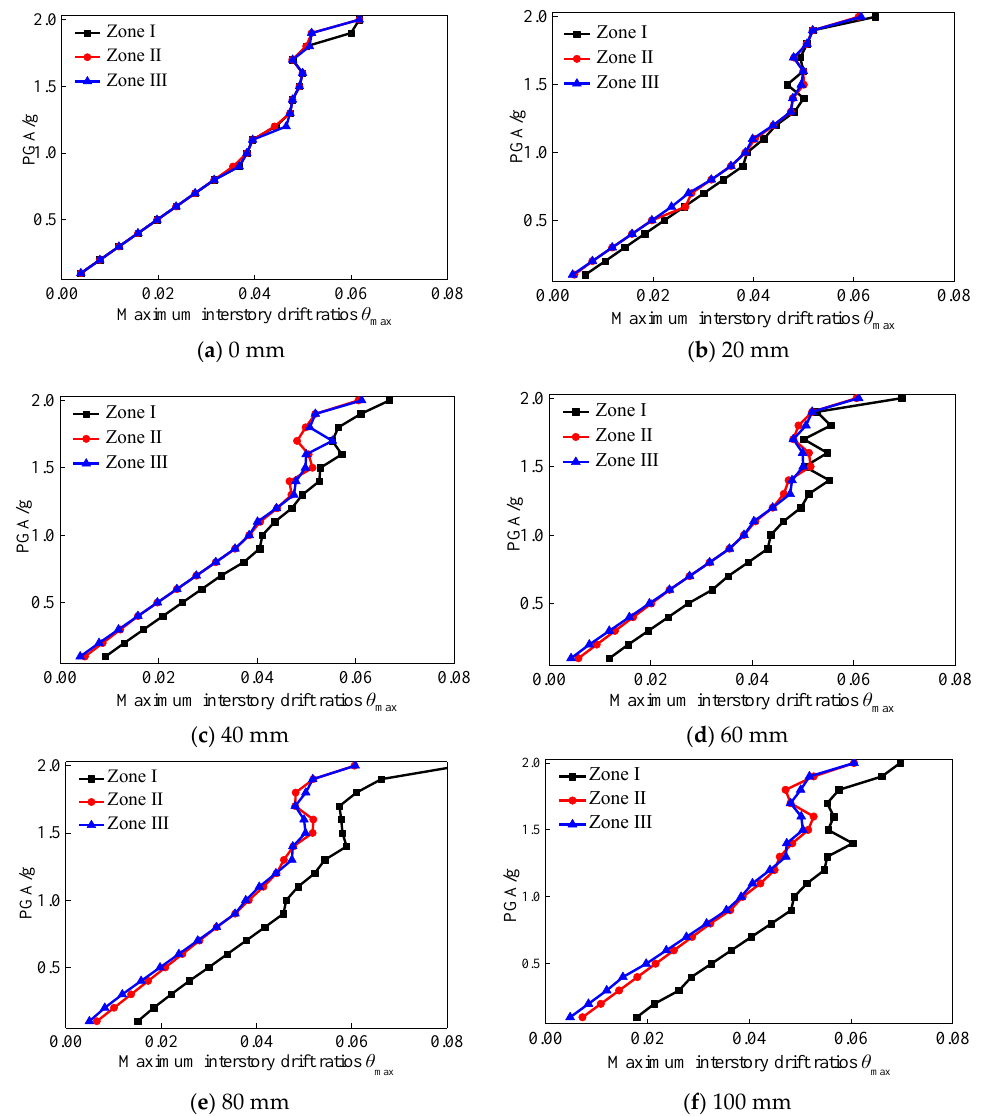
Figure 2. The median incremental dynamic analysis (IDA) curves of di ff erent uneven settlement areas.